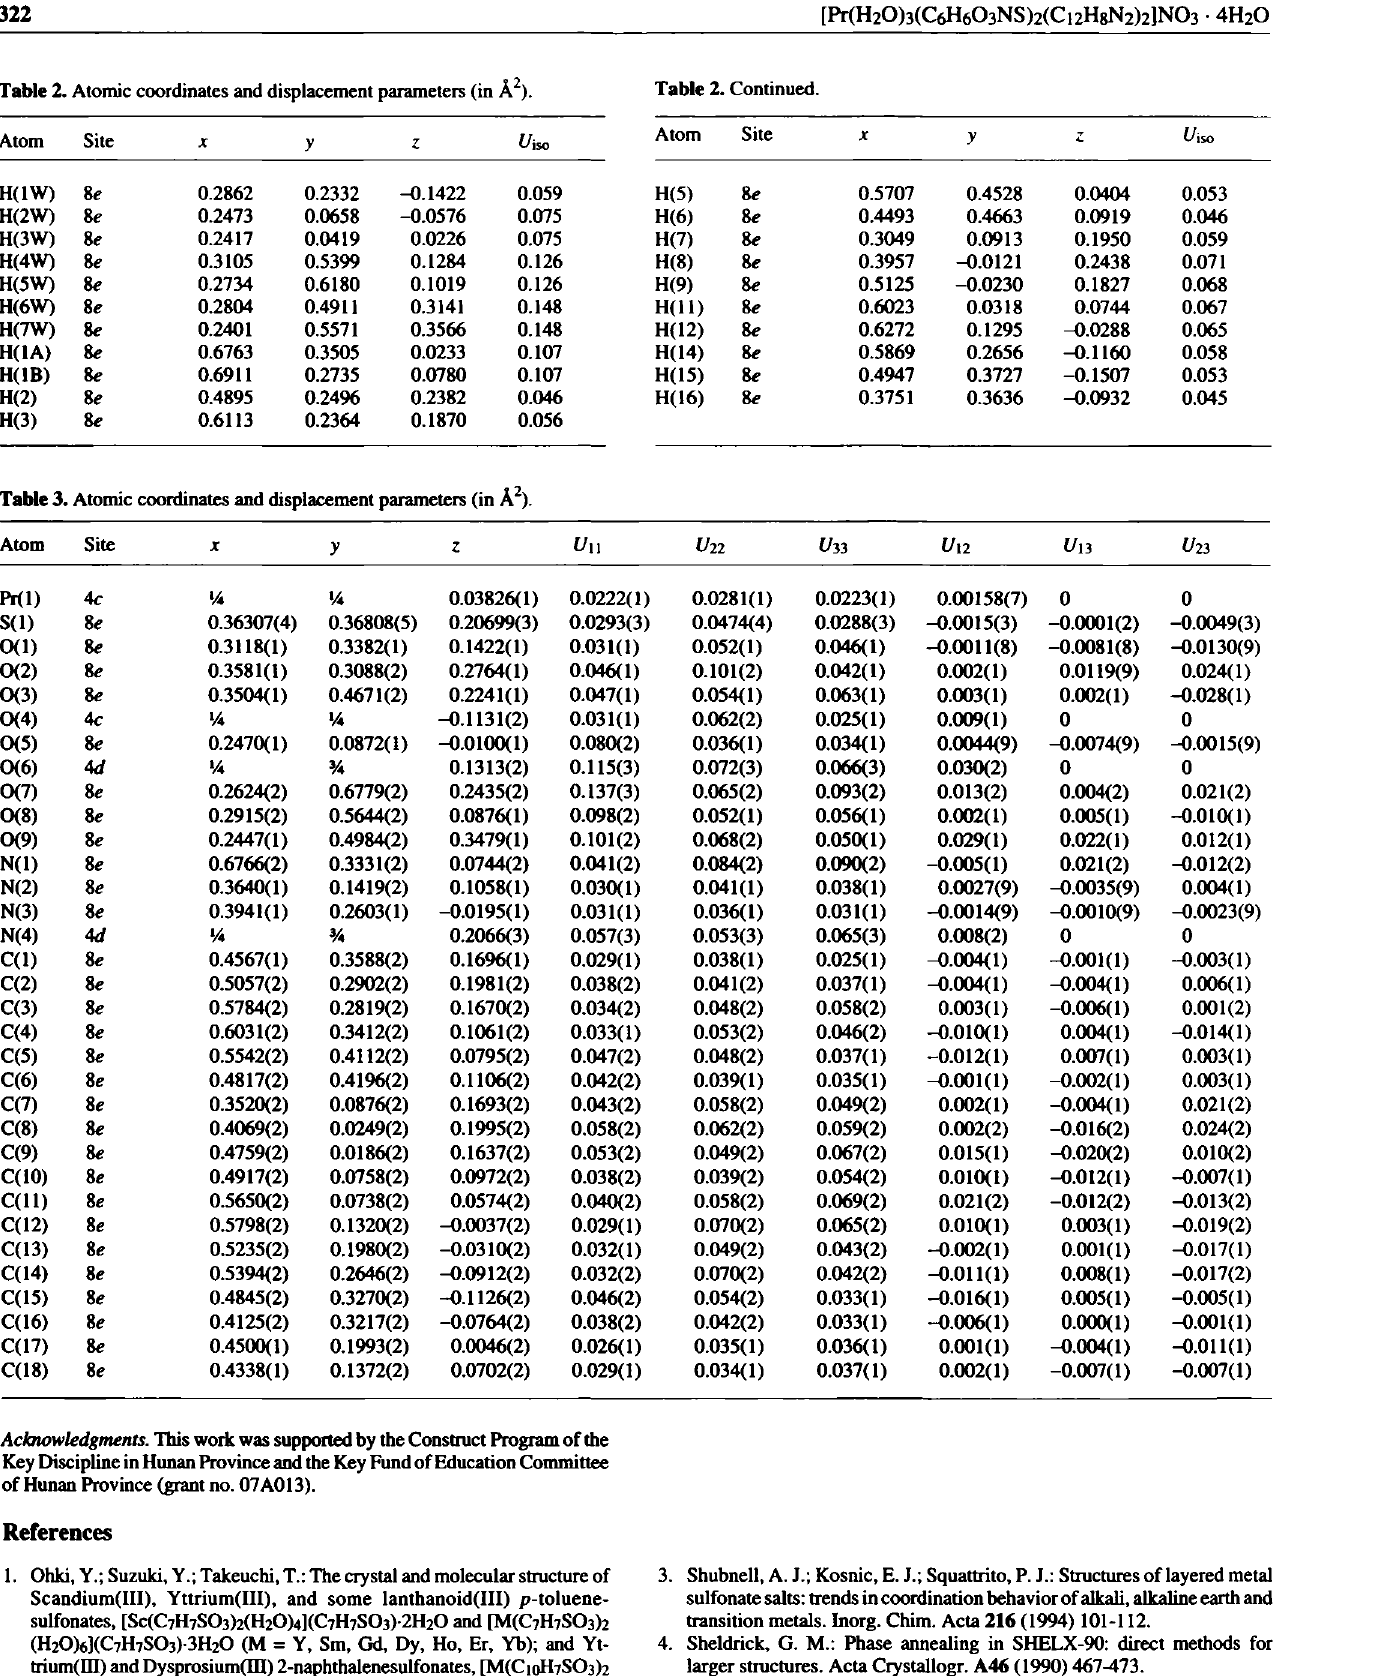
Table 3. Atomic coordinates and displacement parameters (in Â 2